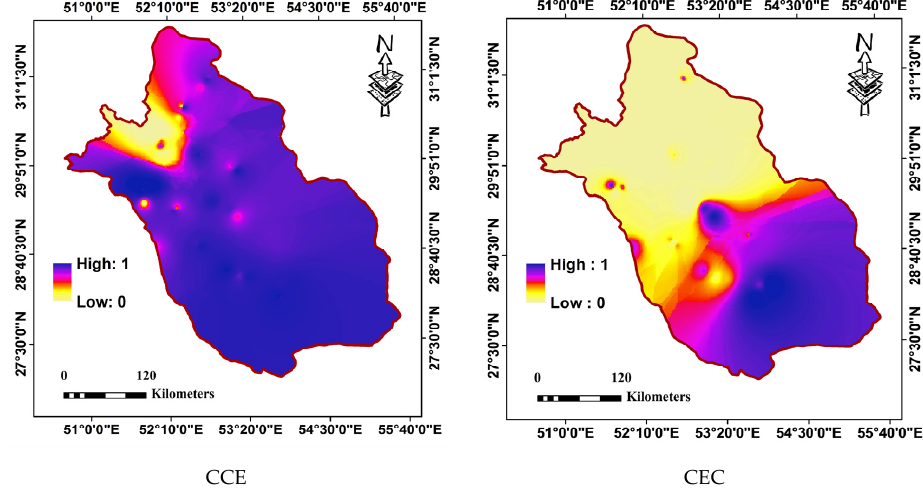
Table 3. Classification of the different KSP conditioning